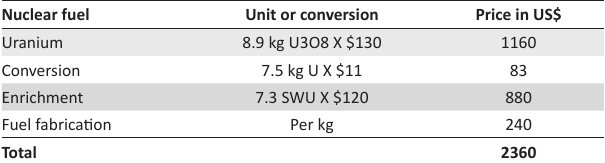
TABLE 1: Cost of nuclear